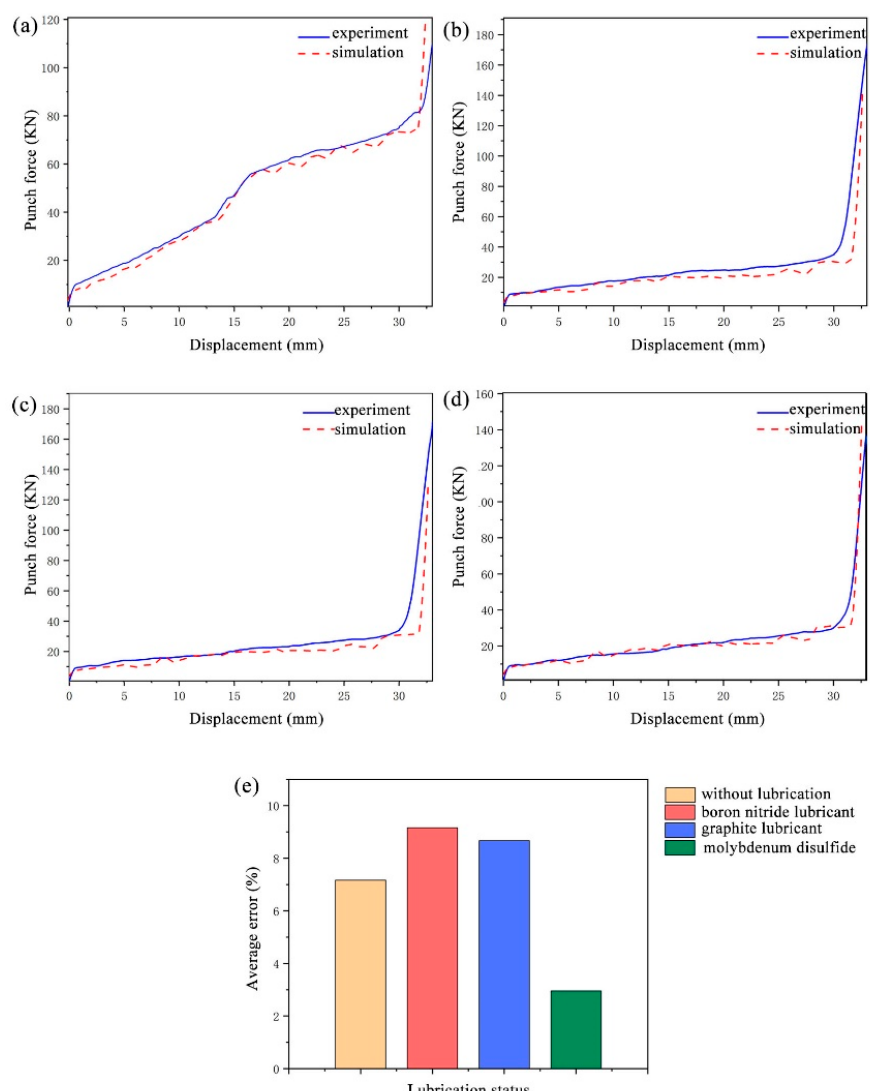
Figure 7. Comparison of experimental and predicted force–displacement curves. ( a ) No lubrication; ( b ) Boron nitride lubricant; ( c ) Graphite lubricant; ( d ) Molybdenum disulfide lubricant; ( e ) Curve fitting error.